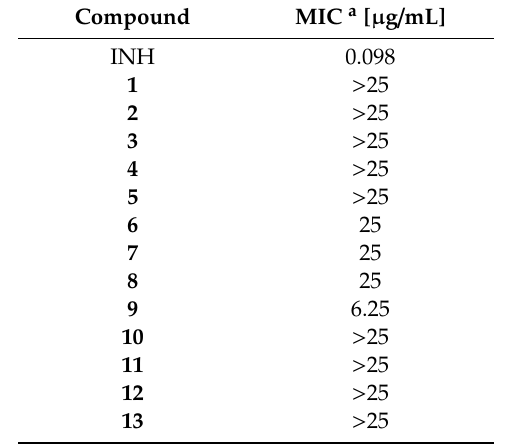
Table 2. The anti-tubercular evaluation of the new compounds.